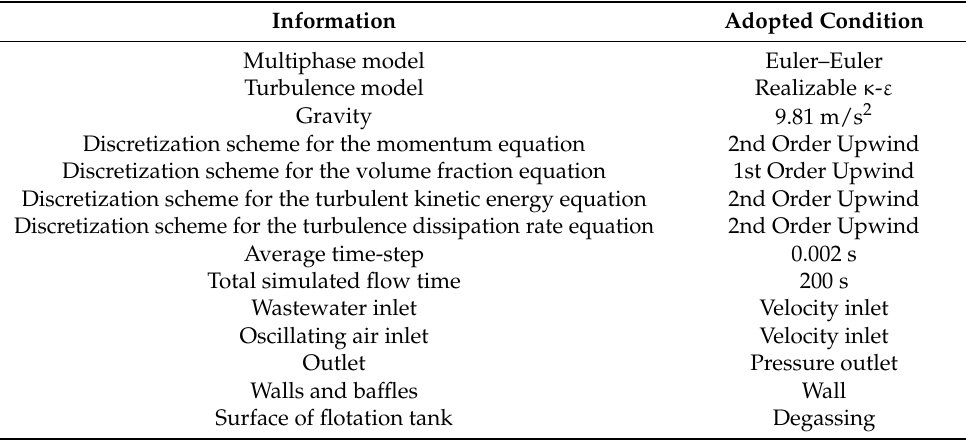
Table 1. Numeric parameters and boundary